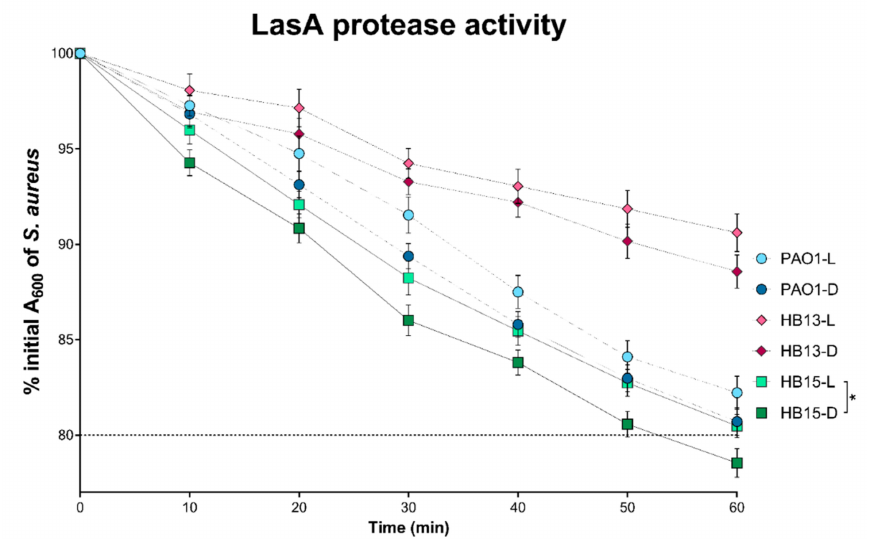
Figure 2. Levels of LasA protease activity of Pseudomonas aeruginosa grown in constant exposure to full-spectrum light (L) and total absence of light (D). LasA protease activity measured as the decrease in the absorbance at 600 nm of a S. aureus boiled culture [22]. The dotted line represents the